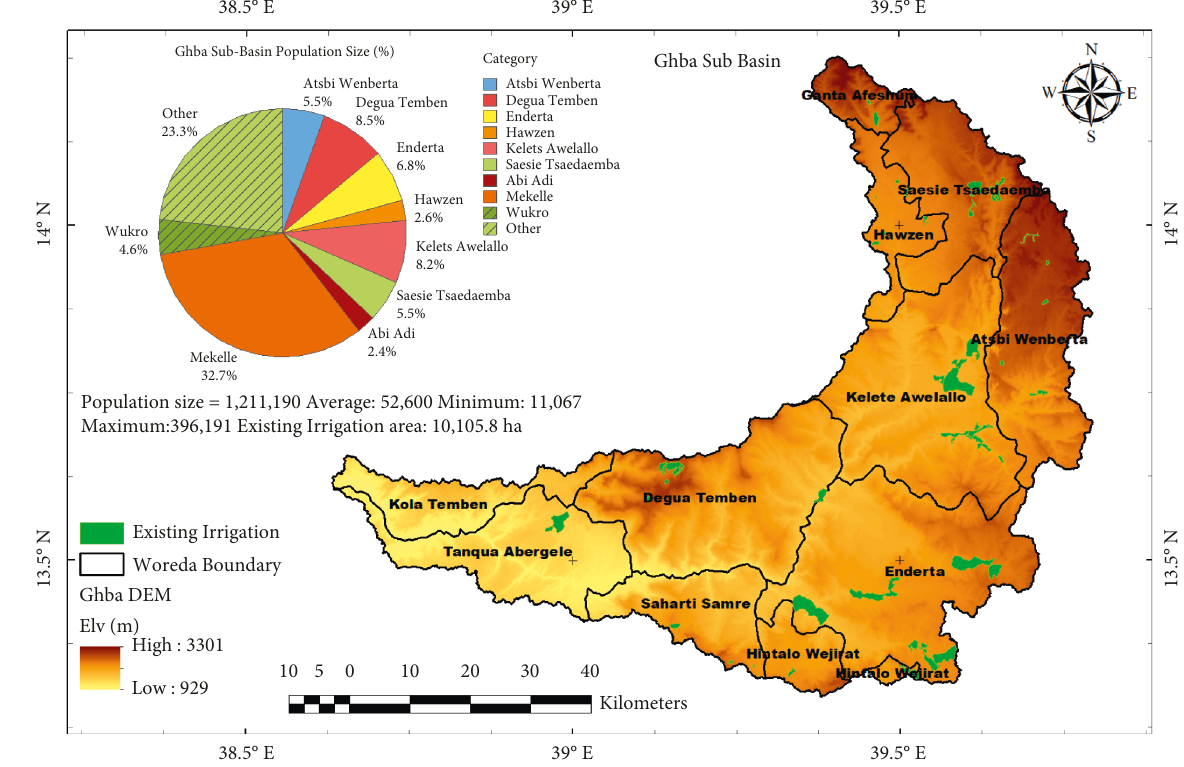
Figure 5: Existing irrigated area and population size distribution in the subbasin at each Woreda. Table 9: Current estimated irrigation water demand of the